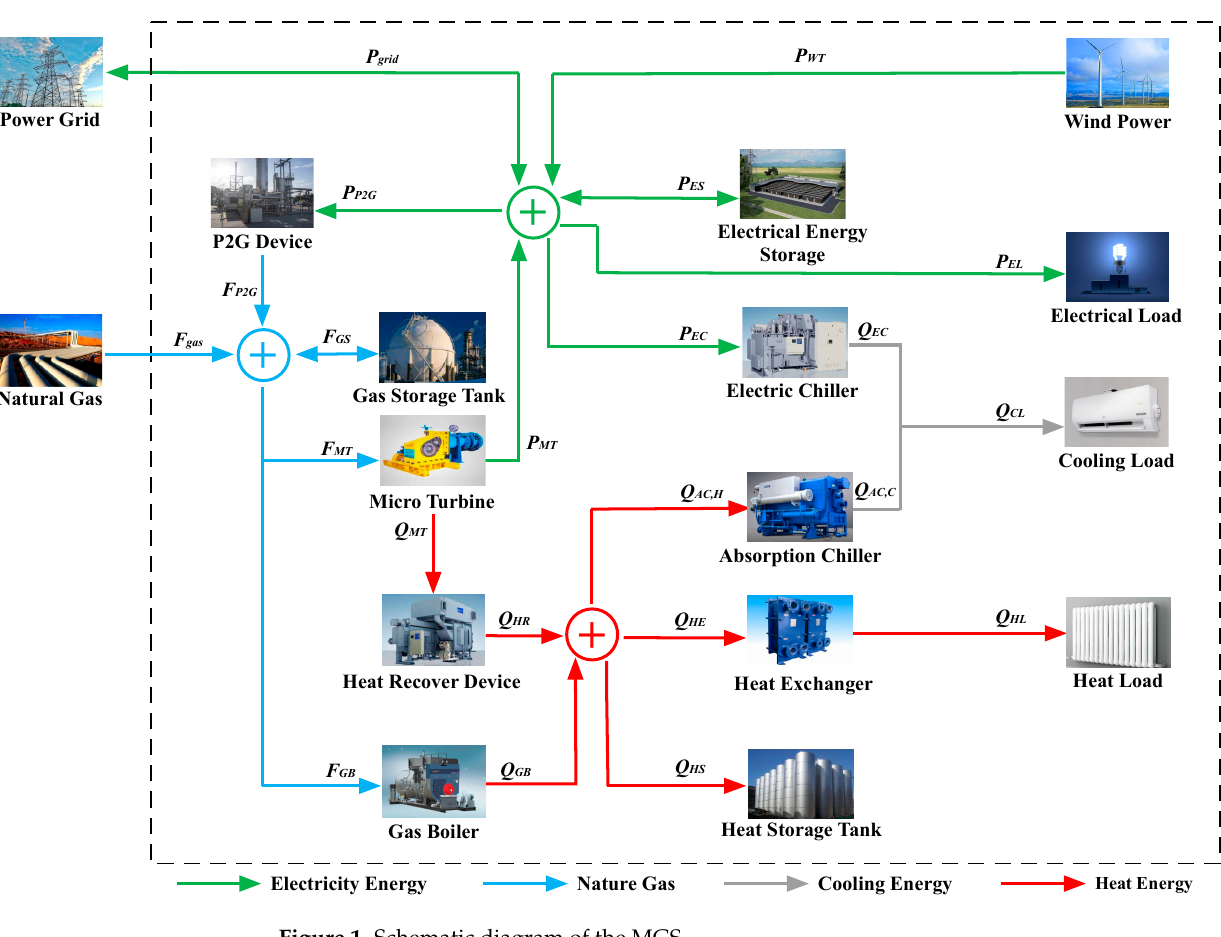
Figure 1. Schematic diagram of the MGS.